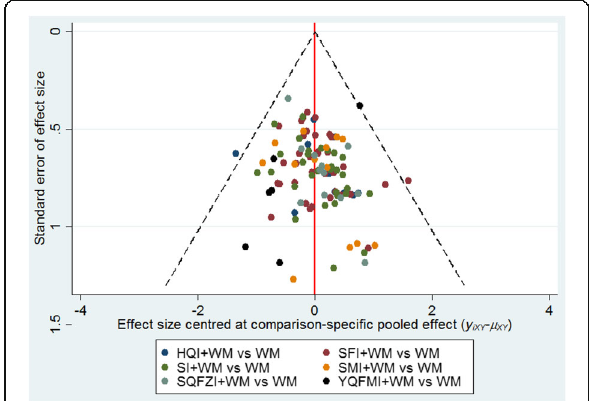
Fig. 5 Funnel plot of the clinical effective